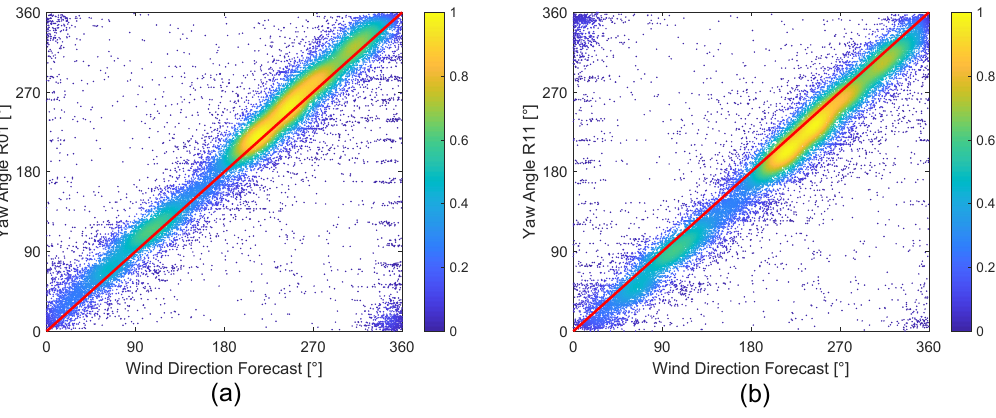
Figure 4. Density plots between forecast wind direction and observed yaw angles for ( a ) wind turbine R01 and ( b ) wind turbine R11 for lead time 72